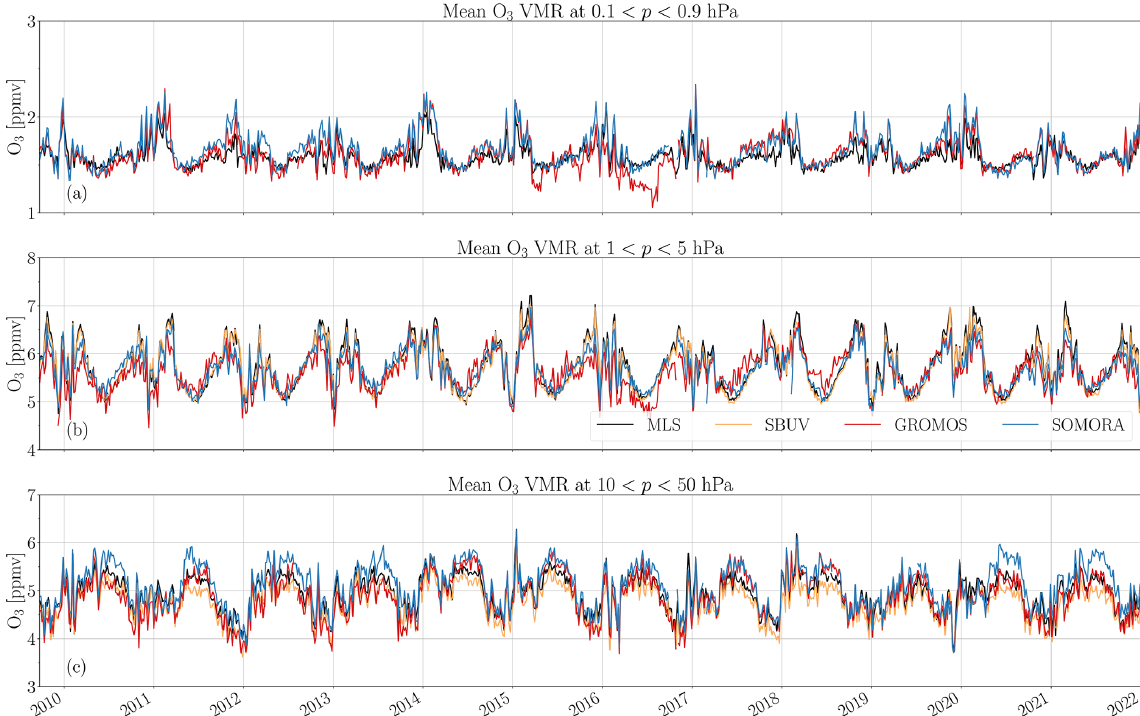
Figure 10. Weekly averaged ozone VMR from MLS, SBUV, GROMOS and SOMORA at three pressure intervals: (a) lower mesosphere, (b) upper stratosphere and (c) lower stratosphere. The SBUV dataset extends only up to 0 . 5hPa and is therefore not shown in panel (a)